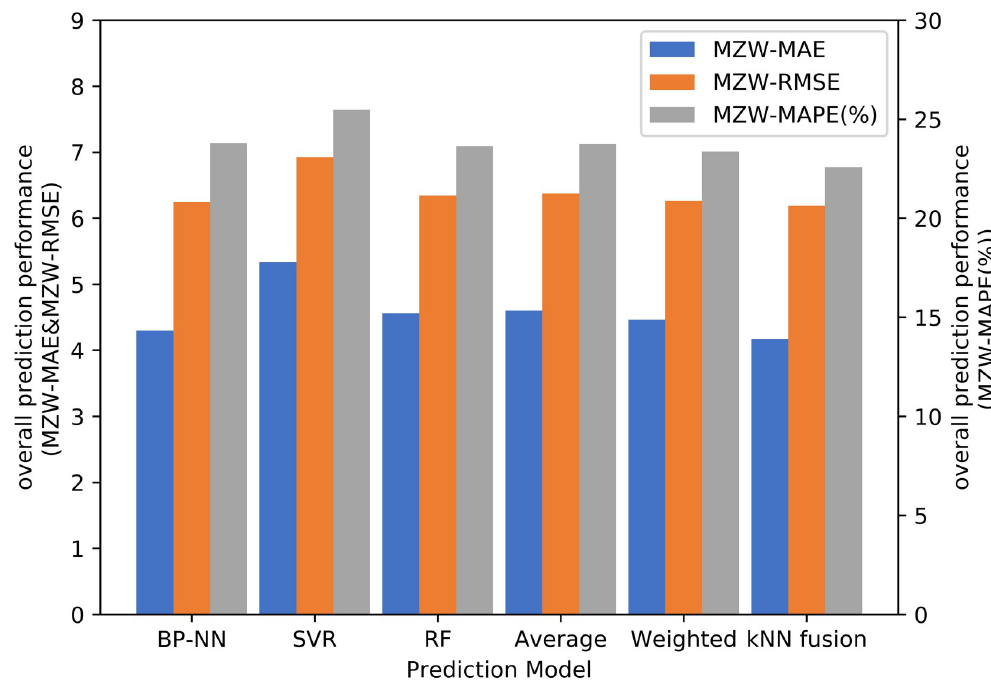
Fig 14. Overall prediction performance analysis.